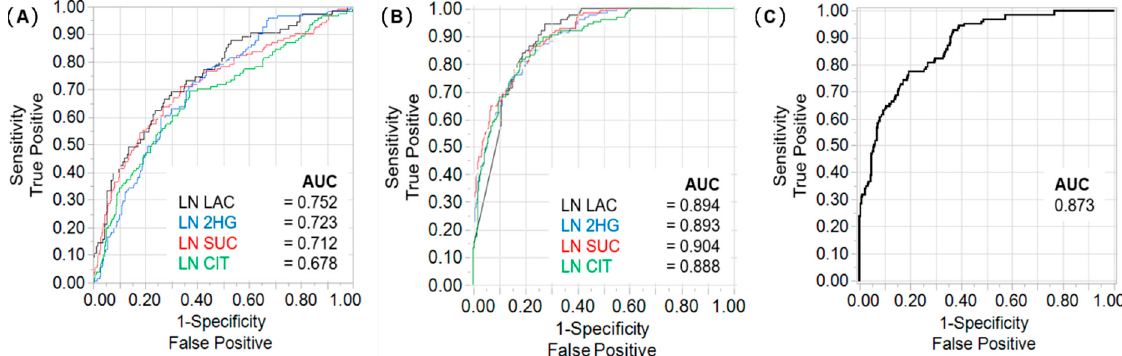
Figure 3. Metabolite signatures showed predictive value for high-risk tumours (TNM stage III and IV). ( A ) Receiver operator characteristic (ROC) curves for single metabolites (LN = logarithm) with areas under the curve (AUC) values; ( B ) Bootstrap forest model of single metabolites showed increased AUCs; sample set, n = 405; ( C ) Combination of metabolites did not improve the predictive power over single metabolites.